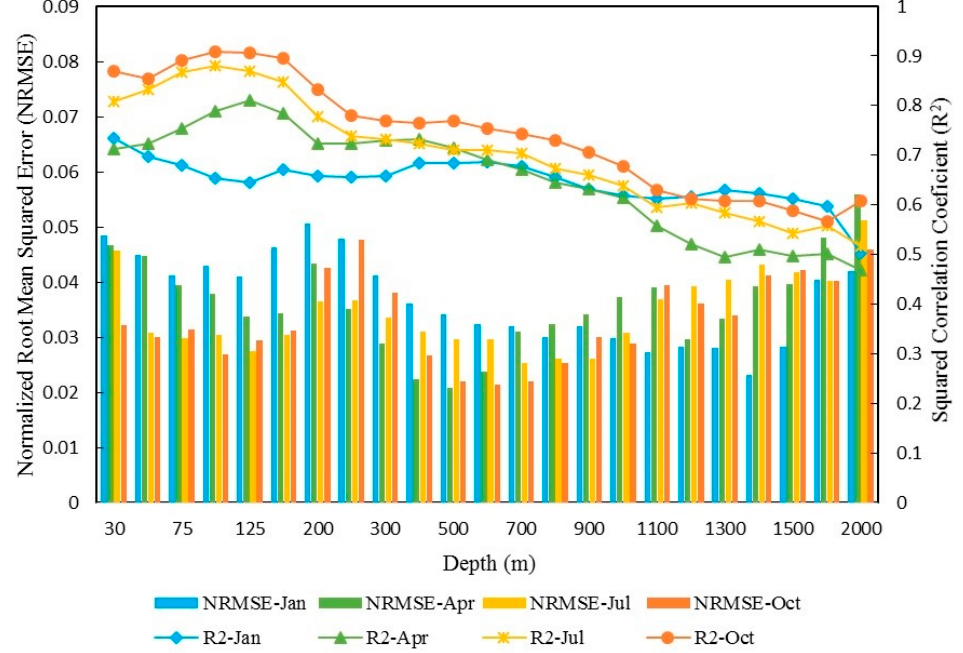
Figure 6. Accuracy evaluation of STA estimation results of the 23 different depths and the different seasons in the global ocean based on the XGBoost model. Blue indicates January (winter), green indicates April (spring), yellow indicates July (summer), orange indicates October (autumn), the lines display R 2 , and the histograms display the NRMSE.